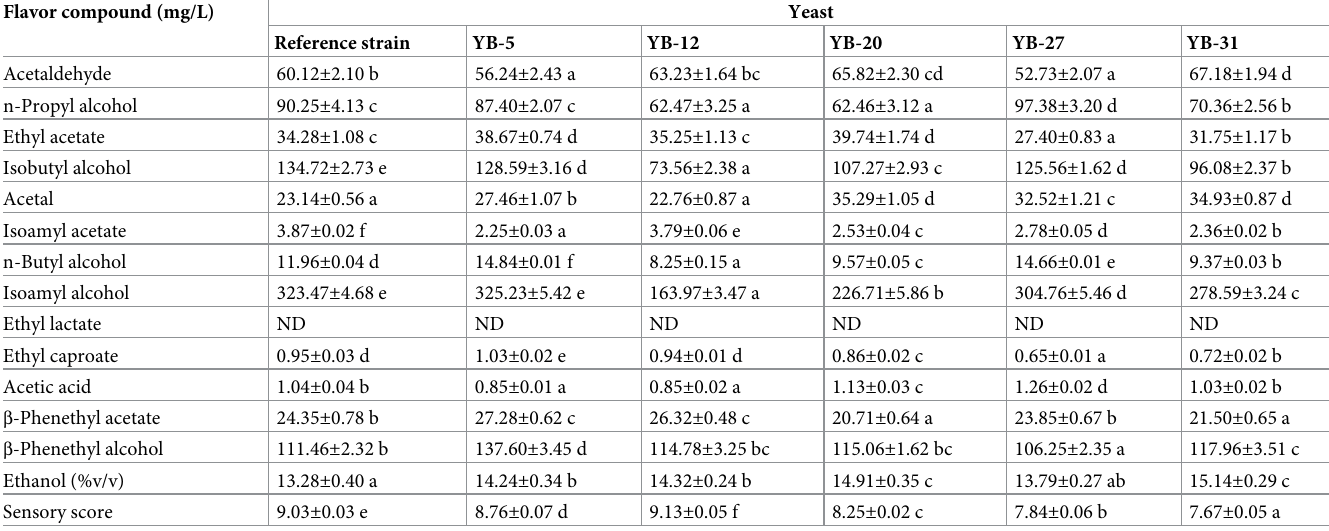
Note: Values followed by different lowercase letters within a single column are significantly different at P = 0.05 according to Duncan’s multiple range test. ND: not